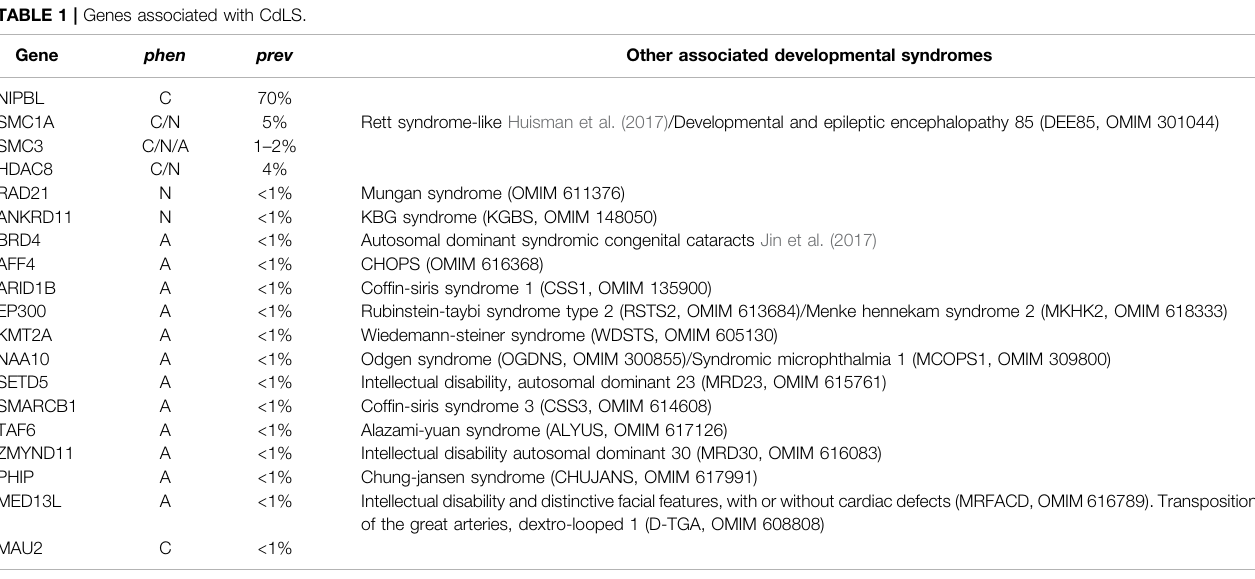
TABLE 1 | Genes associated with CdLS. Gene